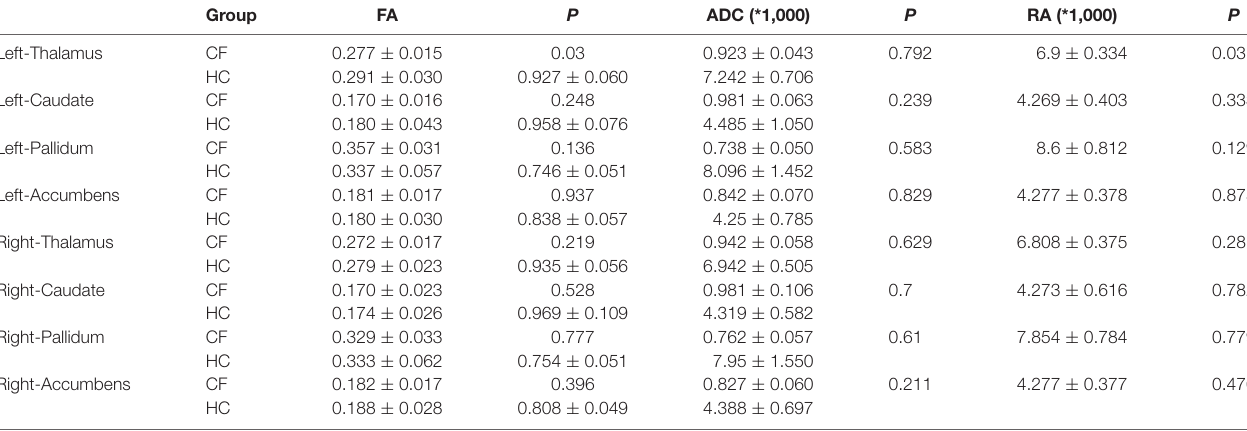
TABLE 3 | FA, ADC and RA of four interested subcortical nucleus between two groups. Group FA P ADC (*1,000) P RA (*1,000) P